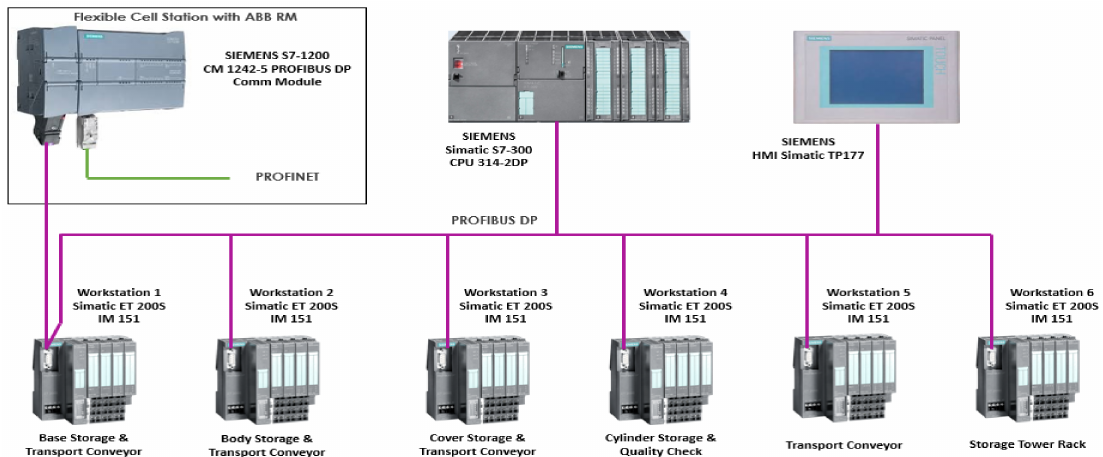
Figure 12. PLC hardware structure of the Mechatronics line